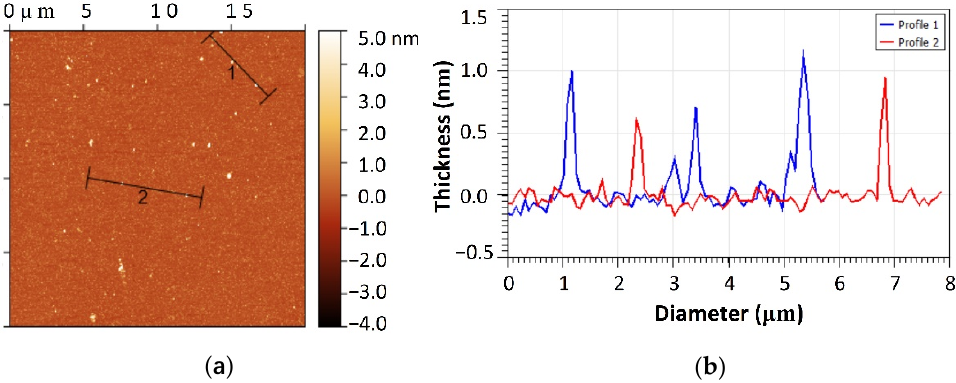
Figure 6. ( a ) AFM image of GQDs-250-12 and ( b ) corresponding height profiles of the lines marked in ( a ).